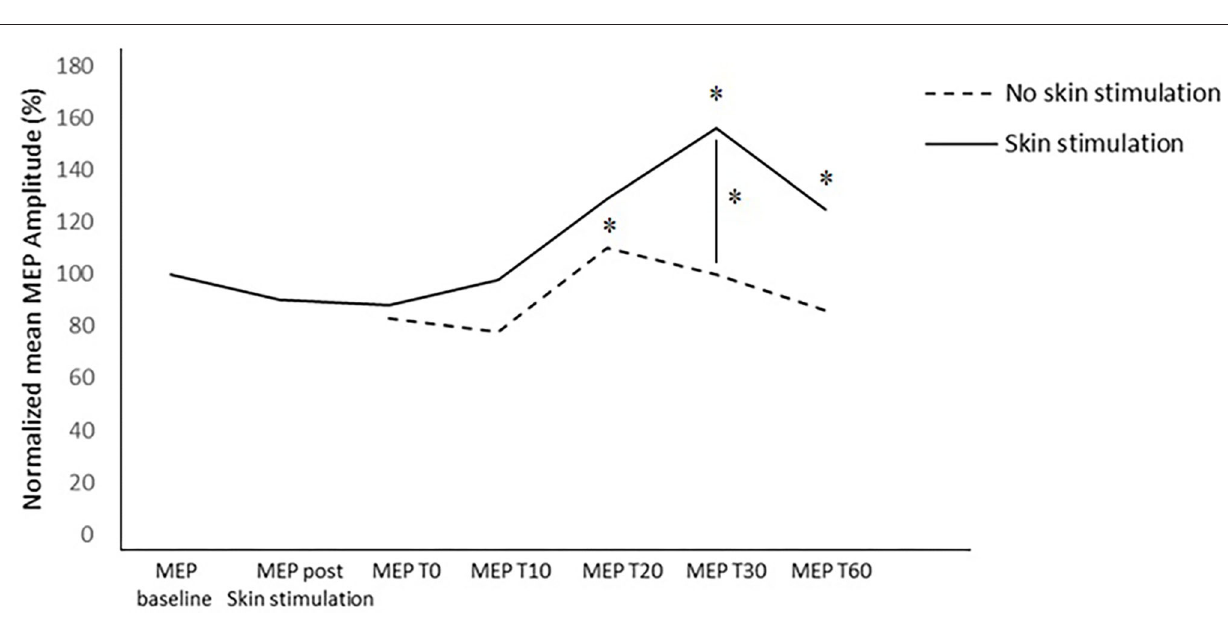
amplitude was found at T30 ( p = 0.027) and T60 ( p = 0.031) compared to the baseline.